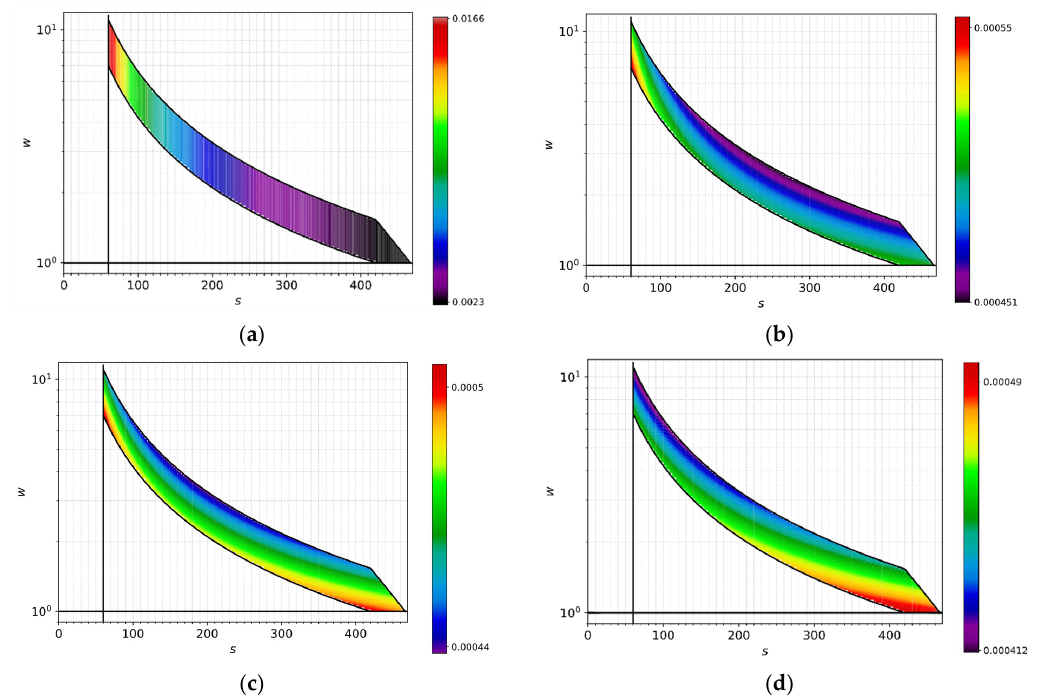
Figure 4. Values of 𝑐 (cid:3081)(cid:3365) for 𝐴𝑜𝐼 (cid:3080) = 420 s , 𝛼 = 0.9 , 𝜆 = 1 (cid:3403) 1800 s (cid:2879)(cid:2869) , and 𝑠 (cid:3040)(cid:3036)(cid:3041) = 60 s , varying 𝛽̅ : ( a ) 𝛽̅ = 0 , ( b ) 𝛽̅ = 0.994 , ( c ) 𝛽̅ = 0.997 , ( d ) 𝛽̅ = 1 (log scale on the y-axis).